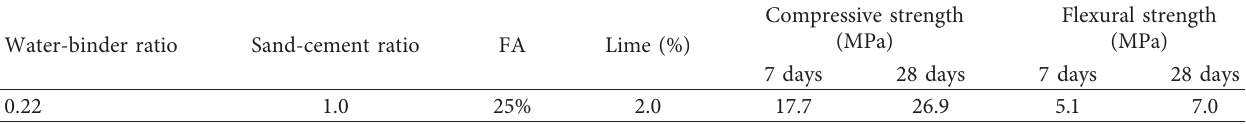
Table 7: Optimal mix proportion and strength.